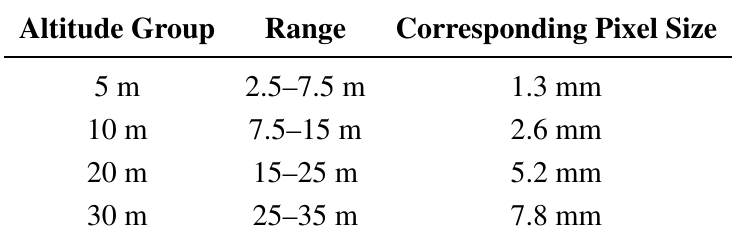
Table 3. In this study, we grouped the images in the following altitude